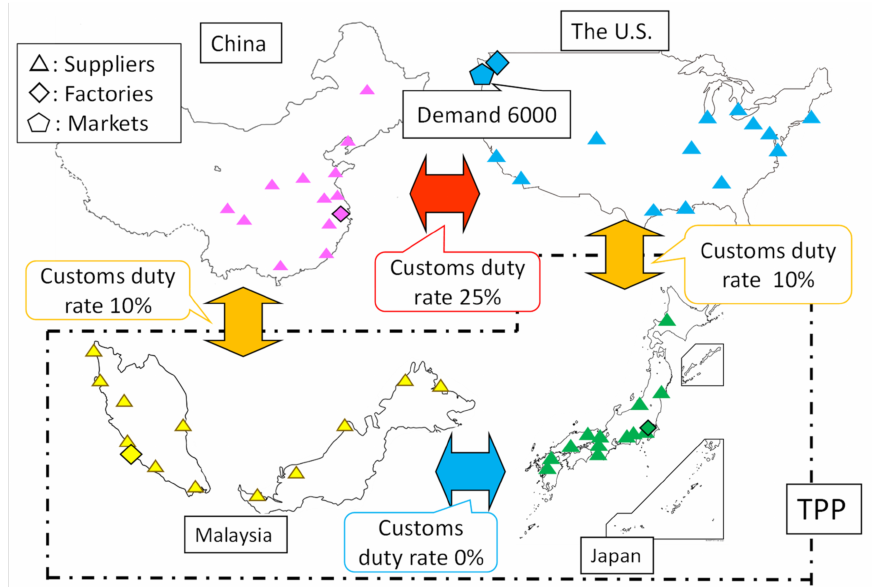
Figure 3. A global supply chain example and the setting. Map Source: https://www.freemap.jp/ (accessed on 30 November